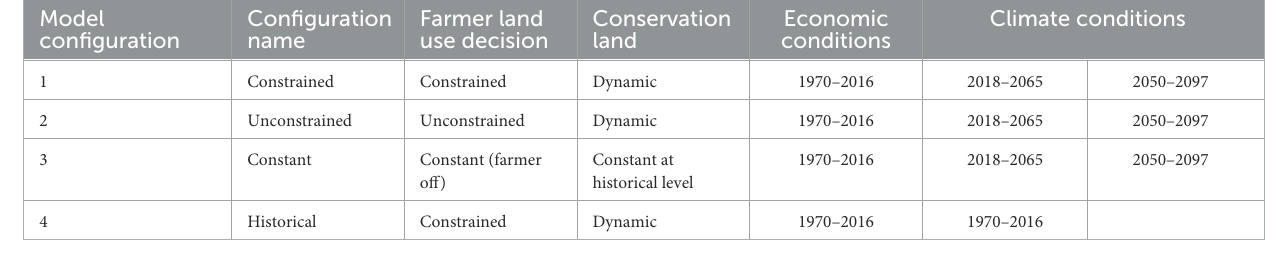
TABLE 4 Model configurations used in scenario analysis.